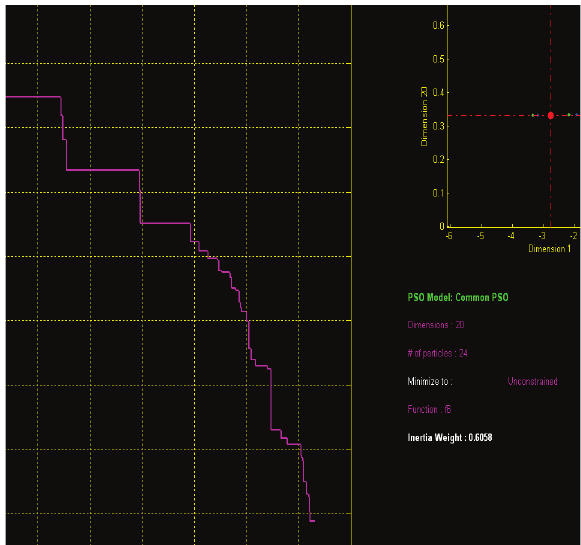
Fig.8. PSO load flow result screen